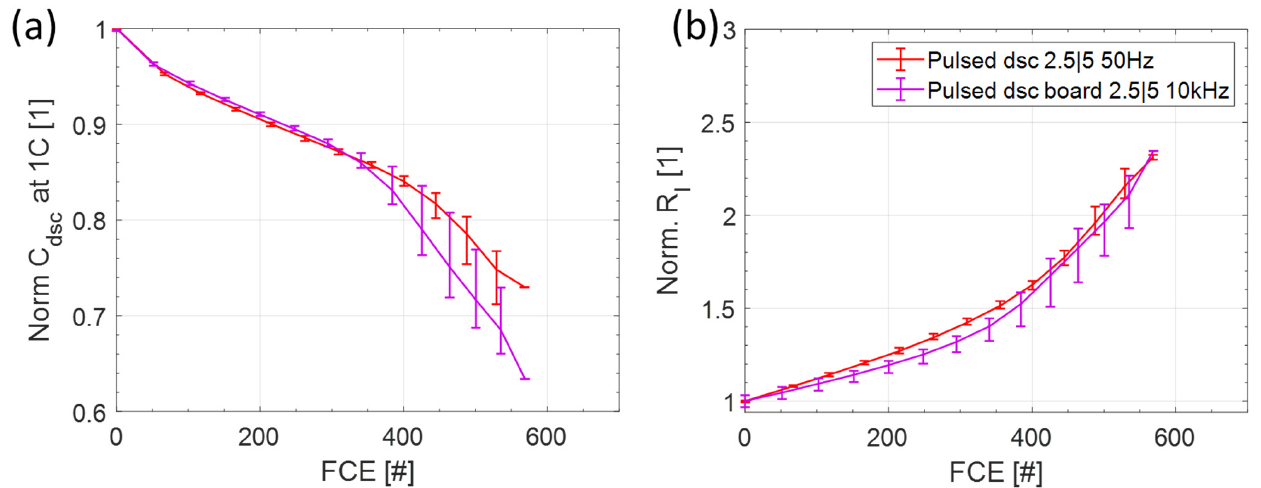
Figure 10. Relative discharge capacity at 1 C ( a ) and relative internal resistance ( b ) of cells switched during discharge (dsc) with a frequency of 50 Hz and 10 kHz.